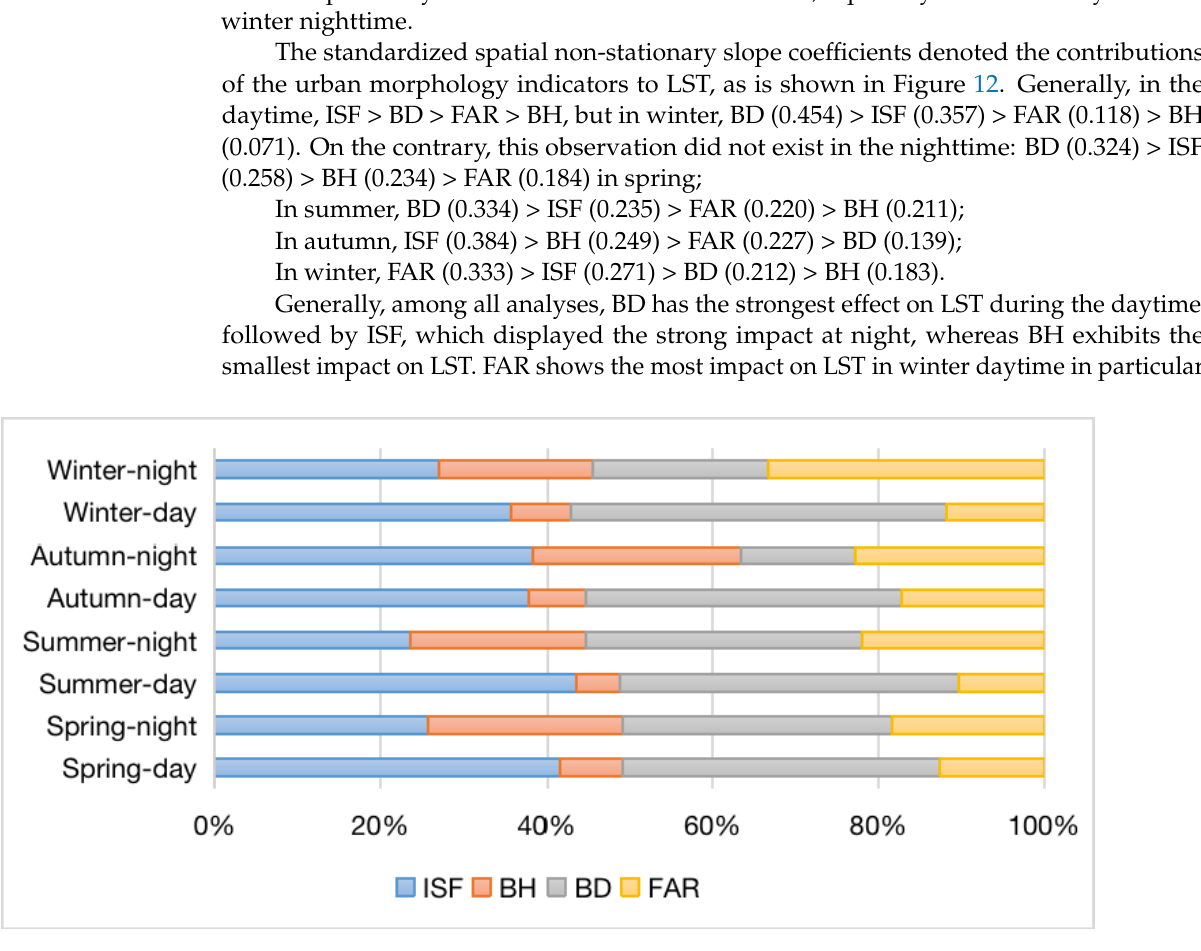
Figure 12. Comparison of the contributions of urban morphology indicators regarding the LST by standardized regression coefficients.